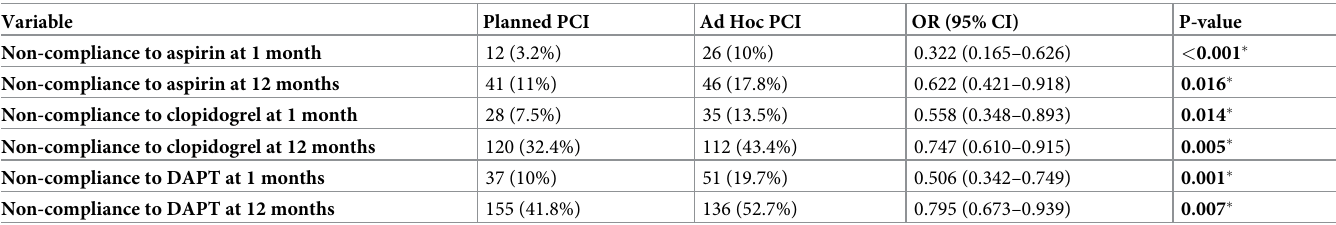
Table 3. Non-compliance of DAPT in planned PCI and ad hoc PCI